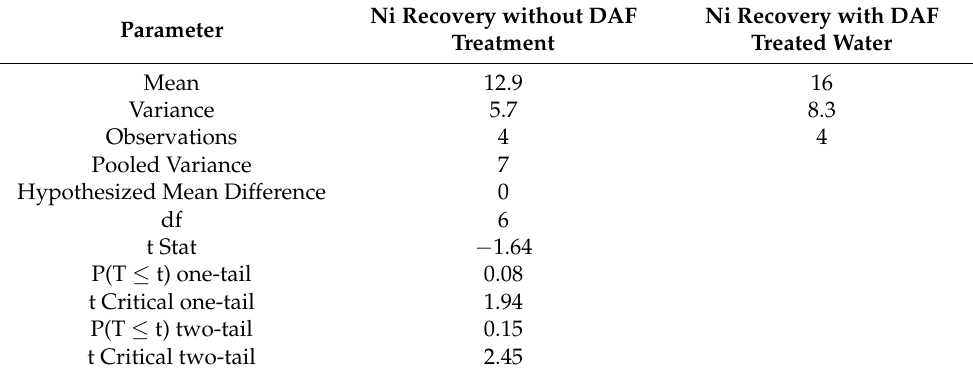
Table 4. Two-sample t -test.